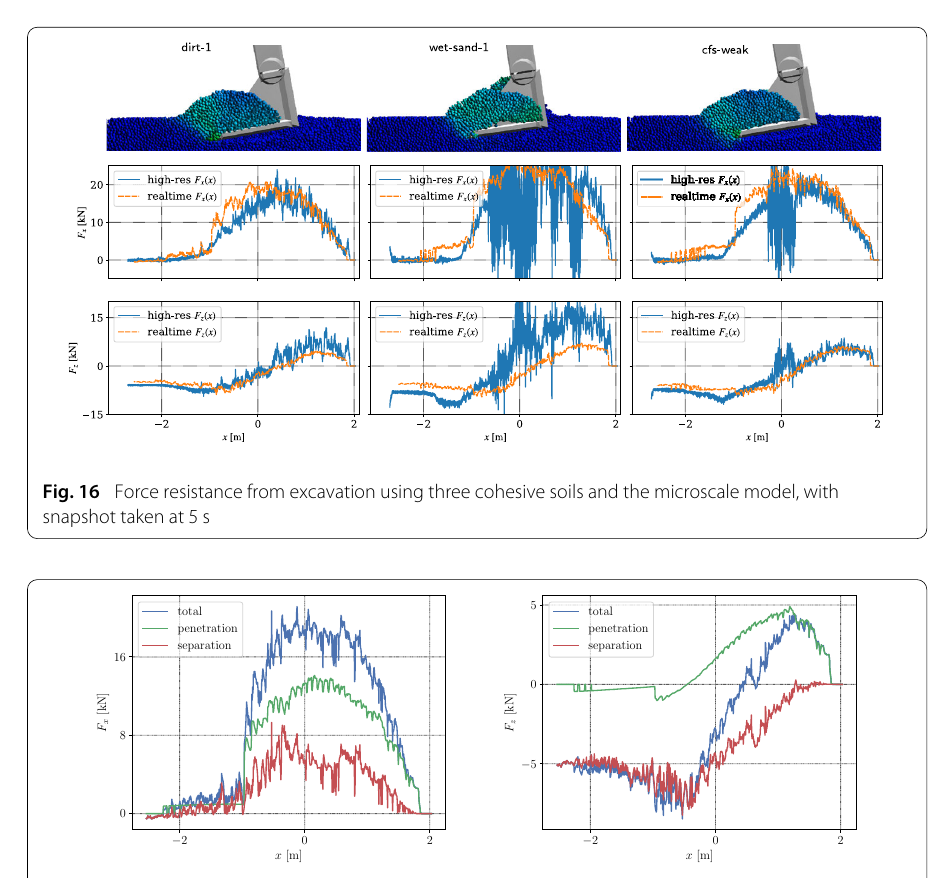
Fig. 17 The digging resistance from excavation in a bed of dirt-1 soil simulated using the